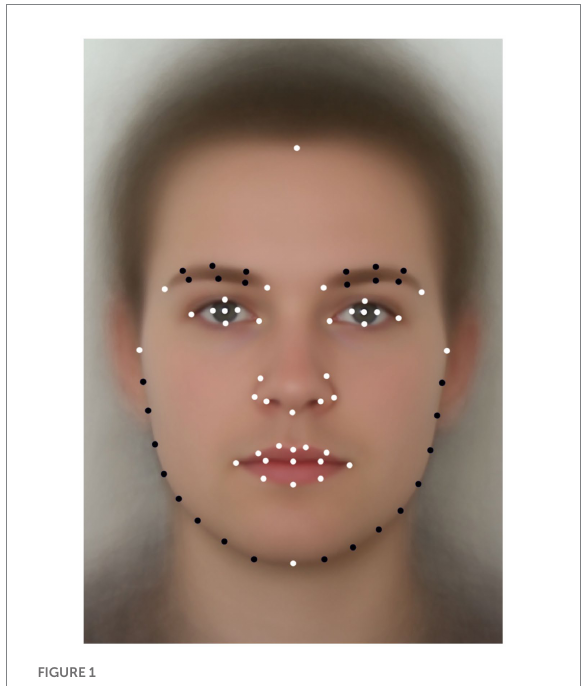
FIGURE 1 Landmarks and semi-landmarks configuration. Averaged portrait with configuration of landmarks (white) and semi-landmarks (black) is presented. For detailed description of the used anthropometric approximations see Rostovtseva et al.